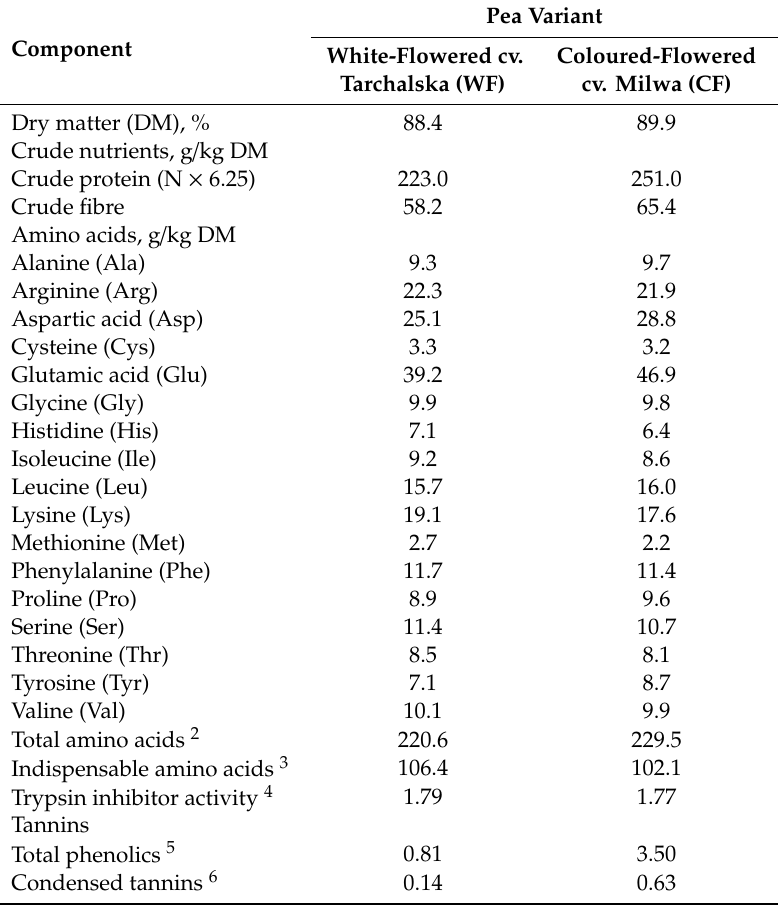
Table 2. Analysed composition 1 of test